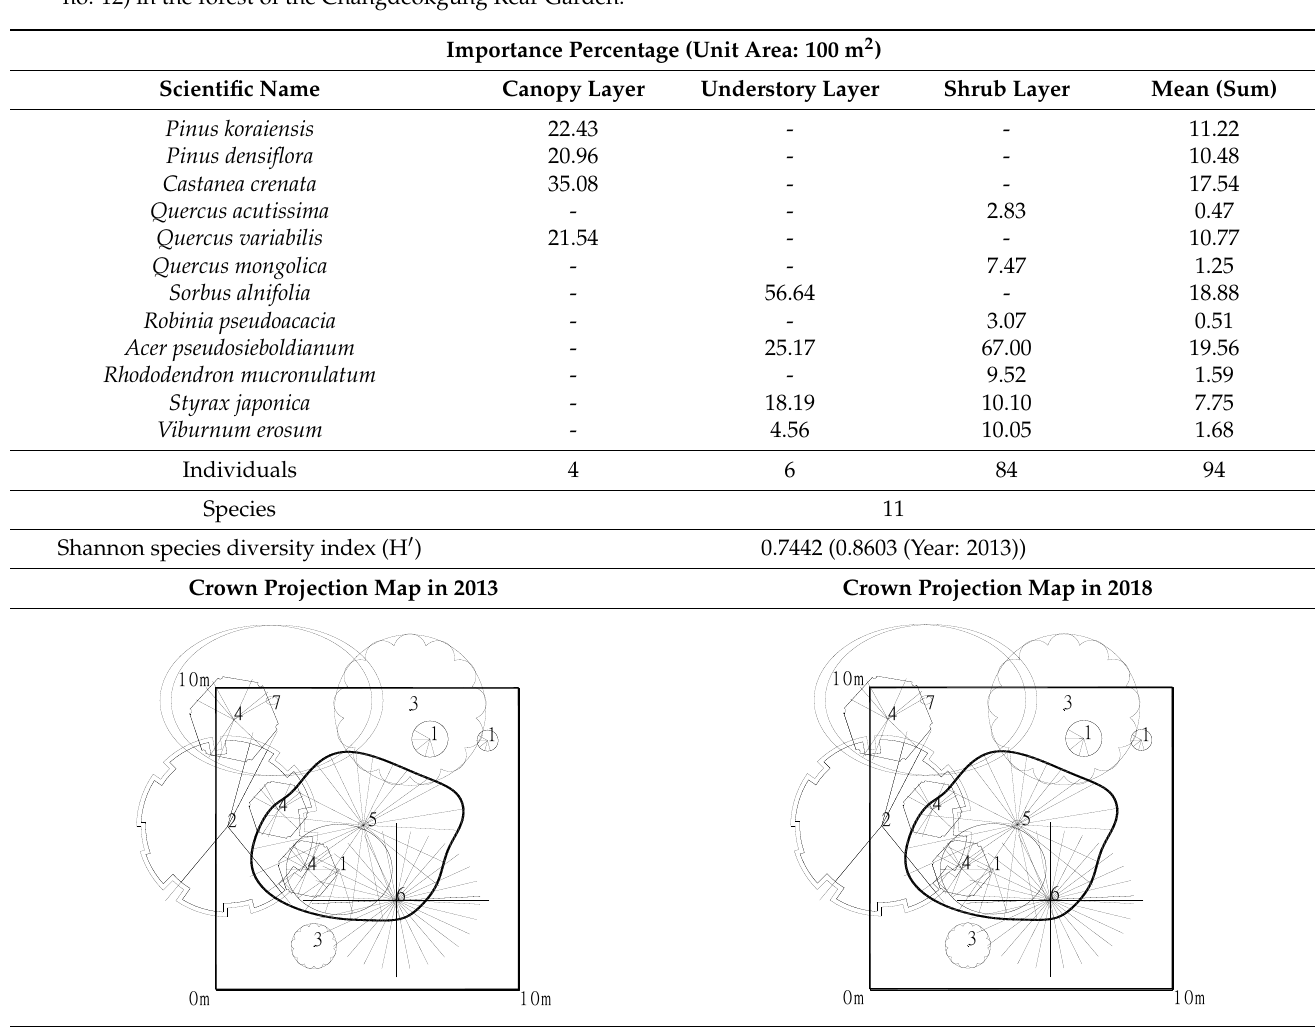
Table 5. Plant community structure of the Pinus densiflora—Pinus koraiensis—Quercus variabilis community (survey plot